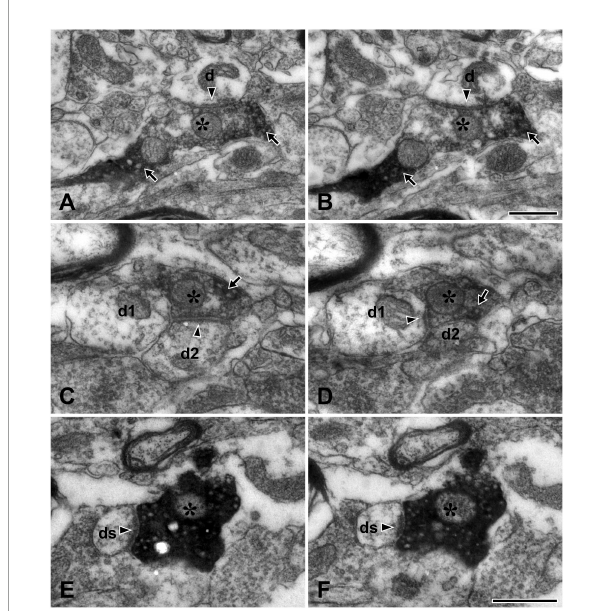
FIGURE2 Electron micrographs of adjacent thin sections ( A and B , C and D , E and F , each pair about 200 nm apart) in the lateral parabrachial nucleus (LPBN) showing TRPV1+ boutons (asterisks) forming synapse with one dendrite (d in panels A,B ), two dendrites (d1 and d2 in panels C,D ) and with a dendritic spine (ds in panels E,F ). The TRPV1+ bouton (asterisk) can be identified by the presence of electron-dense immunoreaction product (arrow) within the axoplasm. Arrowheads indicate synapses. Scale bars = 500 nm in panel (B) (also applies to panel A ) and (F) (also applies to panels C–E ).